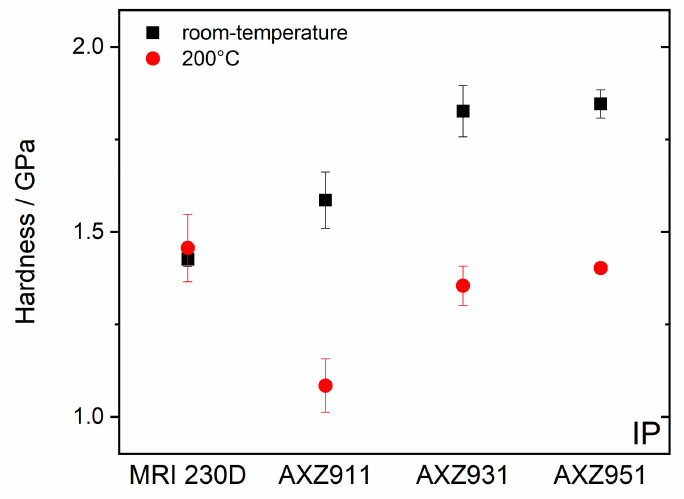
Figure 5. Hardness of the IPs of the different alloys in as-cast condition at 200 ◦ C and at room